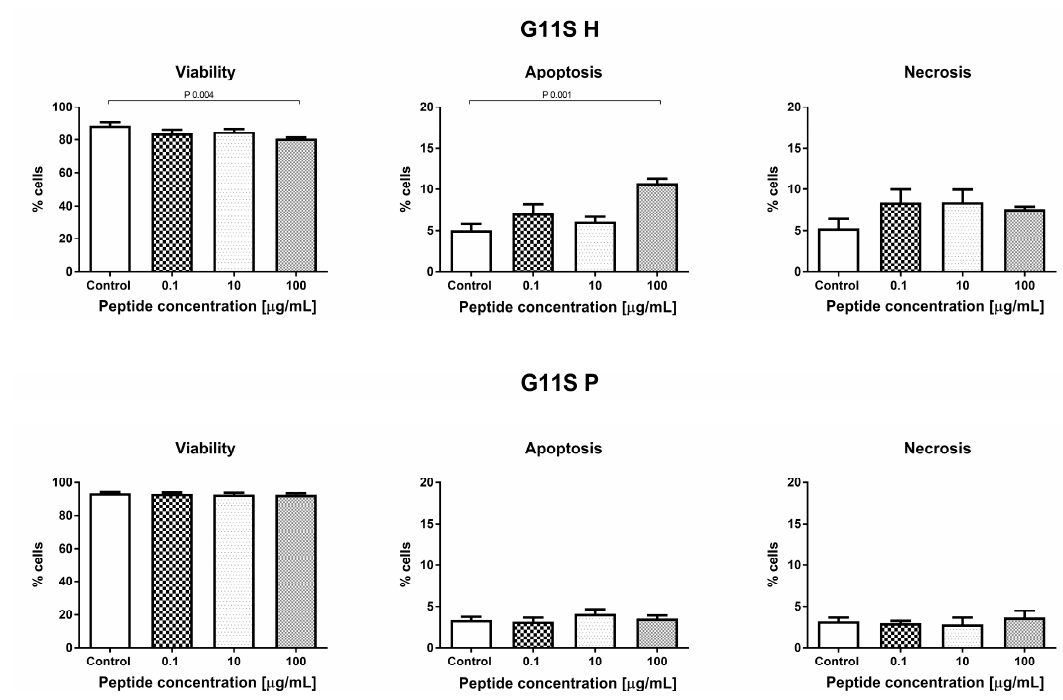
Figure 5. Evaluation of cell apoptosis, necrosis, and viability with G11S H and G11S P.